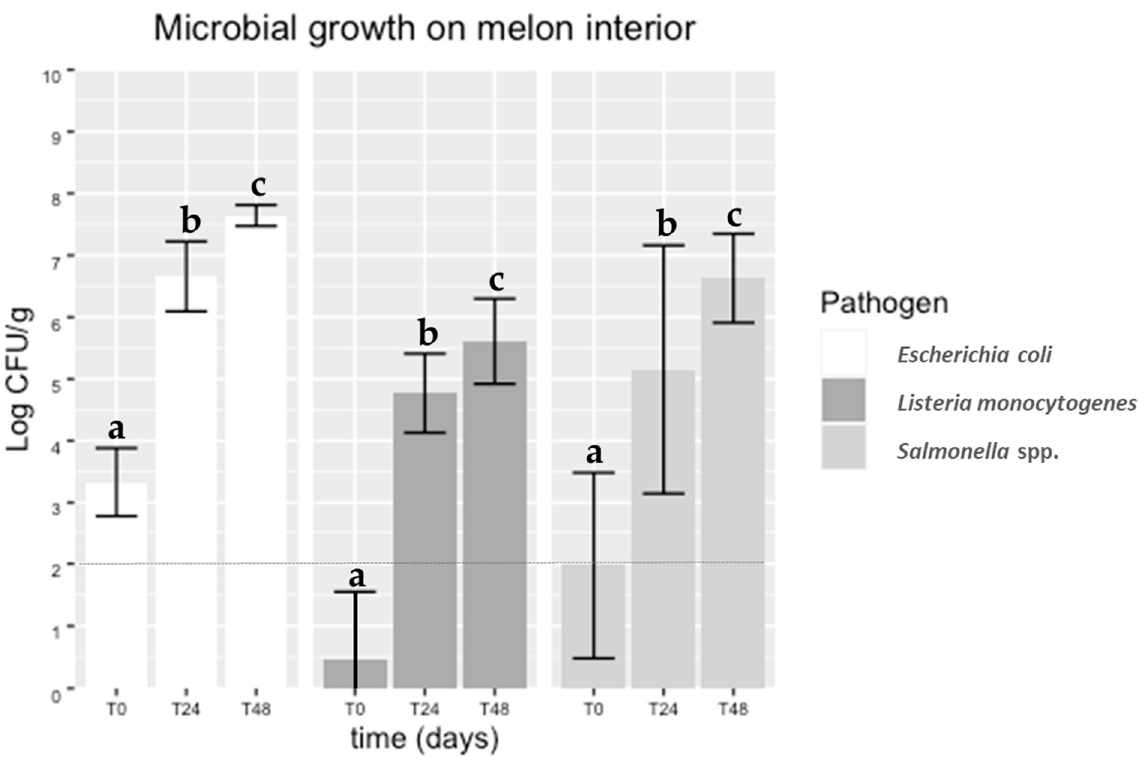
Figure 2. Microbial growth of Salmonella spp., Listeria monocytogenes and E. coli cocktails on the flesh of melons after 0, 24 and 48 h of cutting. The detection limit of the enumeration technique was 2 log CFU/g (dotted line). Equivalent lowercase letters mean no significant differences ( p > 0.05).